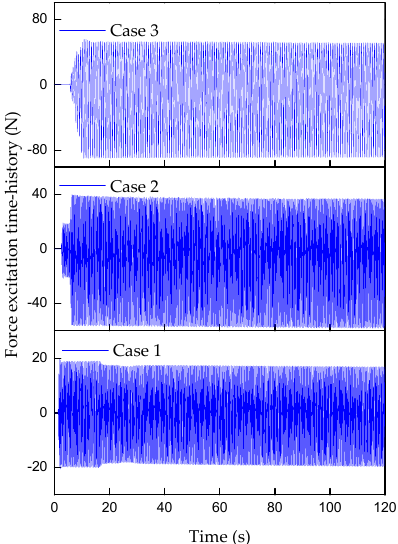
Figure 15. The time histories of force excitation in three damage cases.